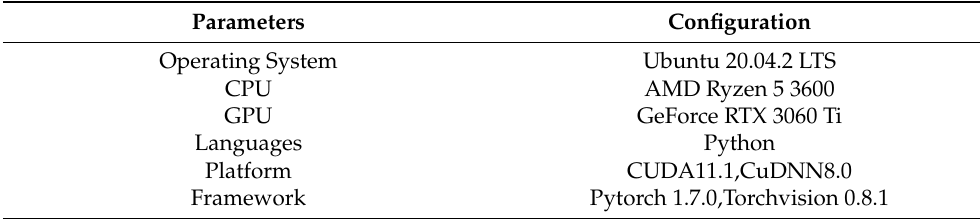
Table 1. Hardware and